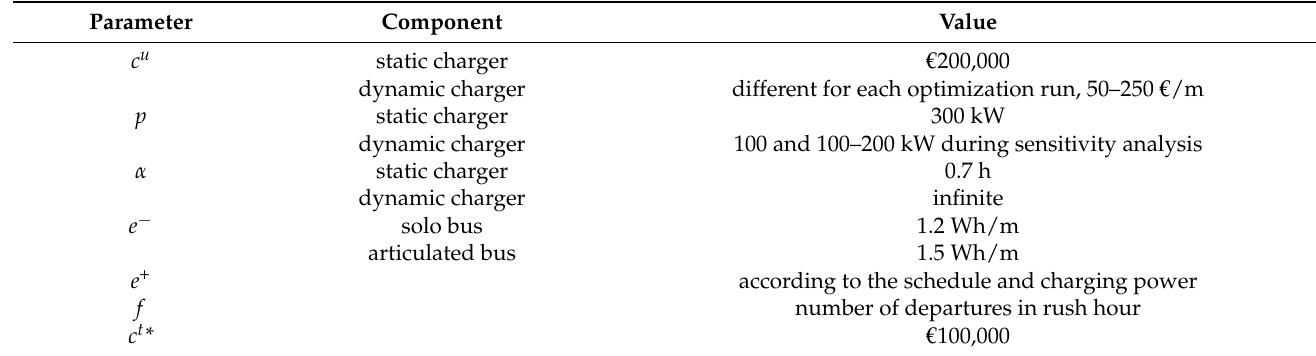
Table 3. Charging infrastructure